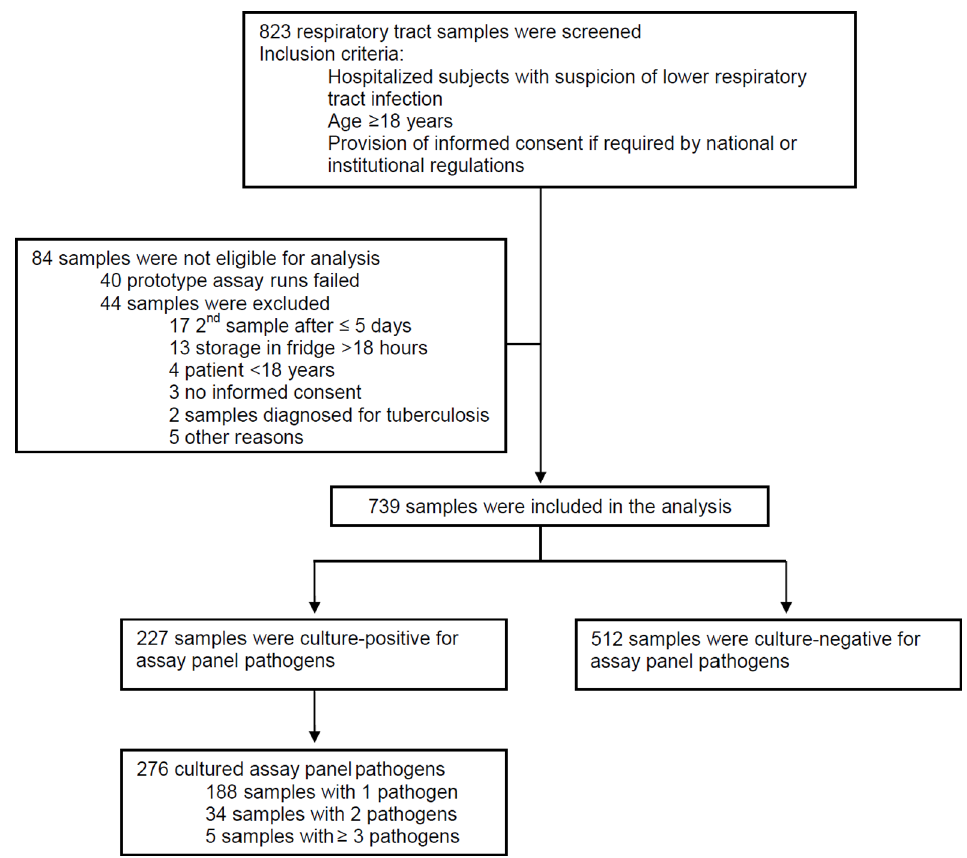
Figure 2. Overview on enrolment and samples for analysis.